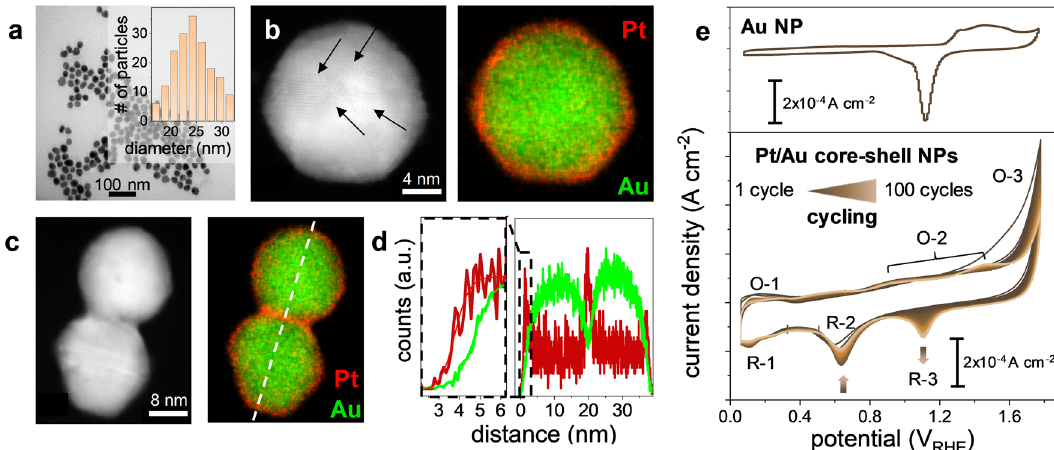
Fig. 2 Characterisation of Pt/Au core-shell nanoparticles. TEM images of Pt/Au core-shell nanoparticles after synthesis ( a ) and the particle size distribution (inset): HAADF micrographs ( b , c ) with the corresponding EDX maps of Pt and Au. The arrows indicate the characteristic twinning observed also for pristine gold nanoparticles. The line scan (white dotted line) and elemental distribution is displayed in d . e ) Cyclic voltammetry of gold nanoparticles (upper part) and Pt/Au core-shell nanoparticles (lower part) in 0.1 M HClO 4 scanning the potential between 0.05 and 1.72 V vs. RHE with a scan rate of 50 mV s − 1 . After the deposition on glassy carbon, carbon monoxide was removed by hydrogen peroxide. The cyclic voltammogram of the as synthesized core-shell particles can be found in Fig.